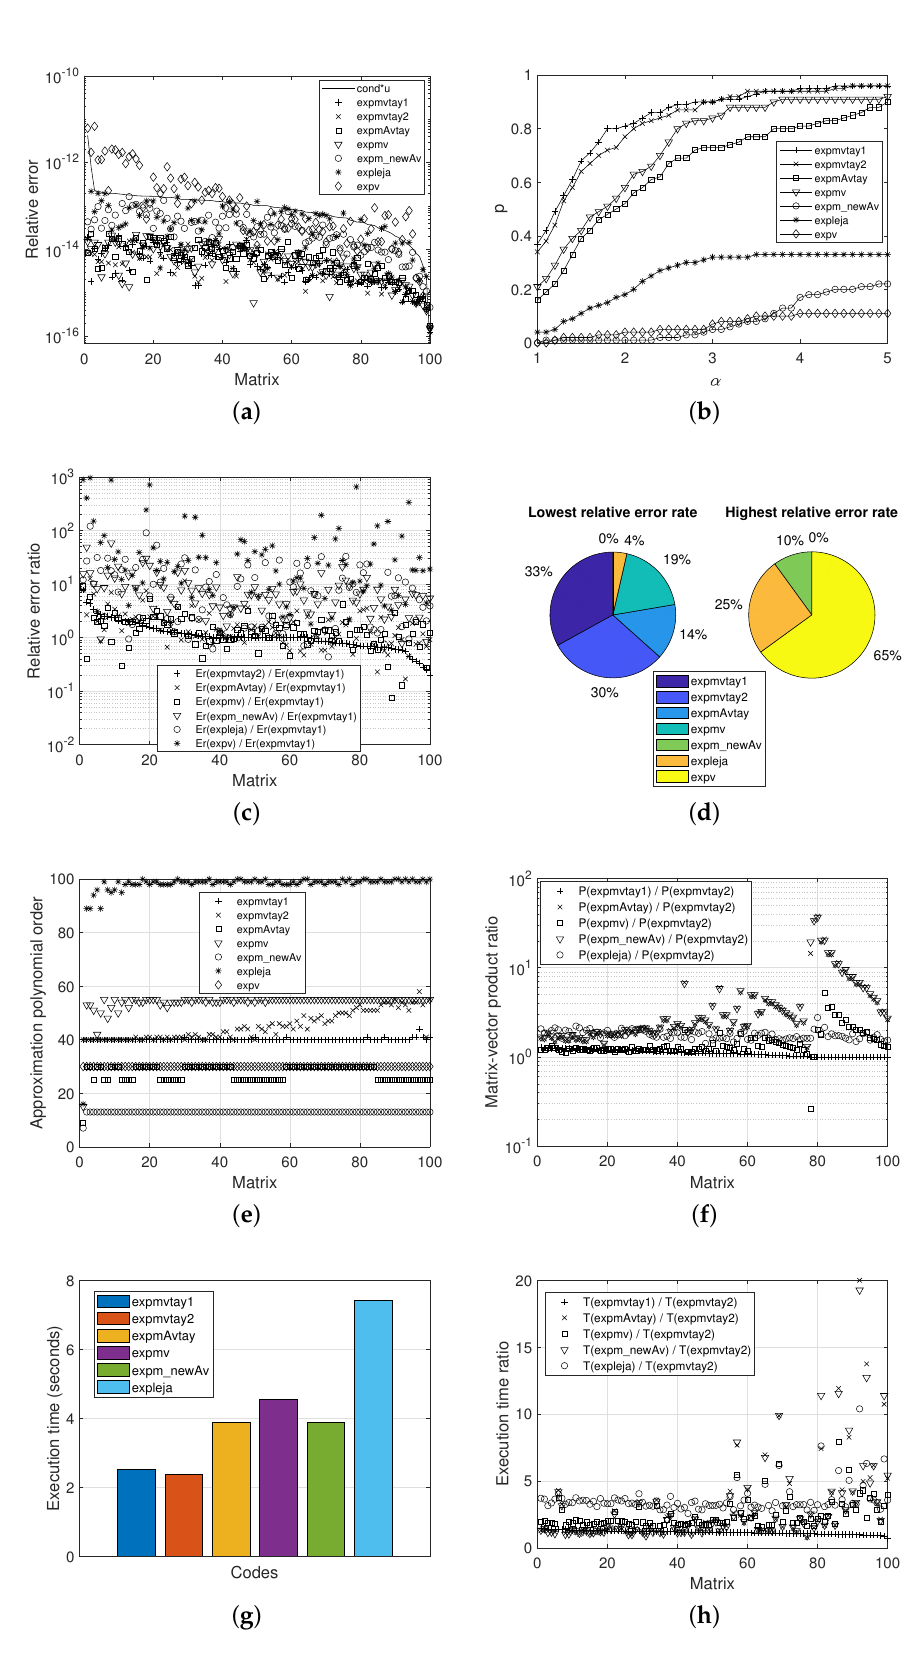
Figure 1. Experimental results for Set 1. ( a ) Normwise relative errors. ( b ) Performance profile. ( c ) Ratio of relative errors. ( d ) Lowest and highest relative error rate. ( e ) Polynomial, interpolation and subspace orders. ( f ) Ratio of matrix–vector products. ( g ) Execution time. ( h ) Ratio of execution